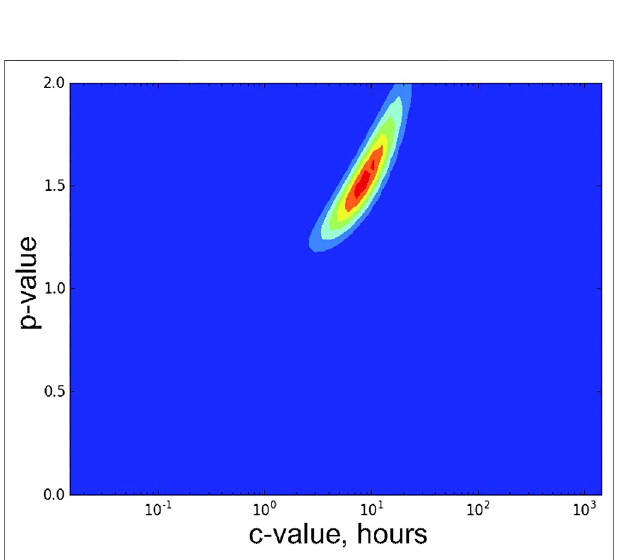
FIGURE 3 | The posterior distribution of the c and p values for Bayesian estimates(Holschneideretal.,2012)foraftershocksoftheM (cid:1) 7.8earthquake of December 5, 1997 in Kamchatka. Light-blue area corresponds to the 95% quantile.